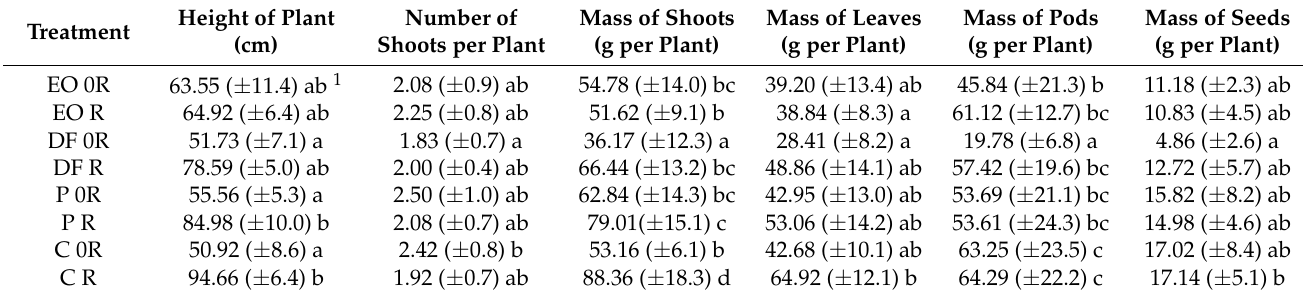
Table 4. The effect of PDSs and bioremediation on the growth of Vicia faba